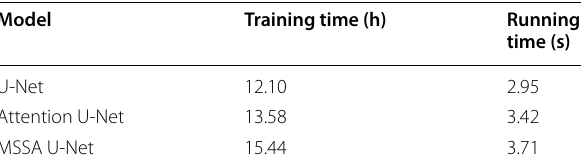
Table 4 Training and running times of three models for the gear pitting dataset